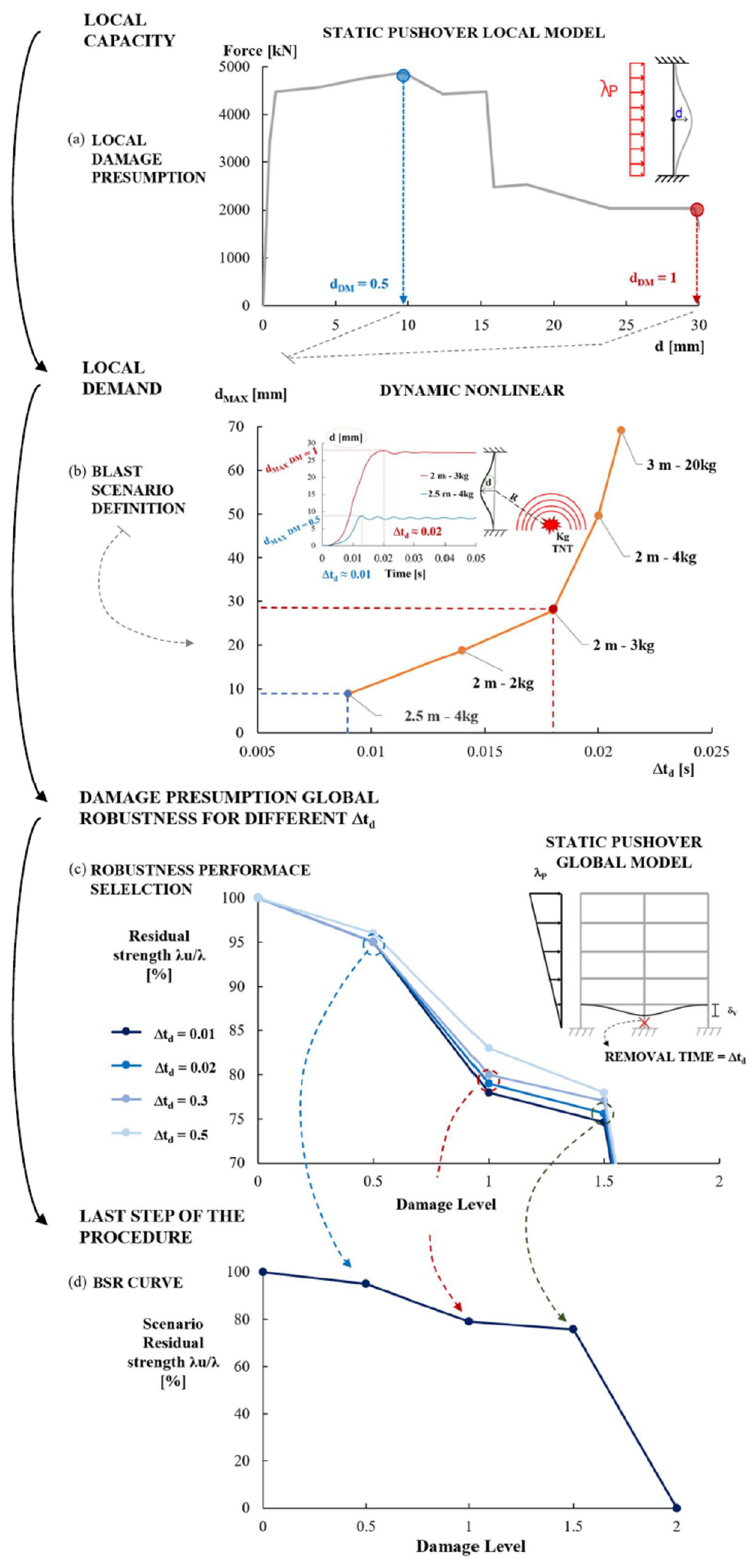
Figure 15. BSR curves evaluation summary. Local damage presumption ( a ); blast scenario definition ( b ); robustness performance selection ( c ); and BSR curve ( d ).